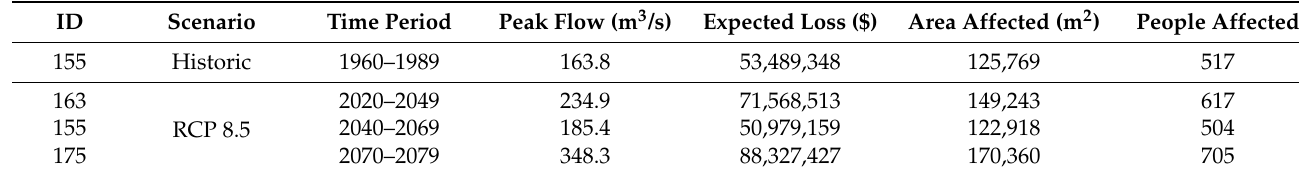
Table 4. Parameters of the worst-case scenarios.